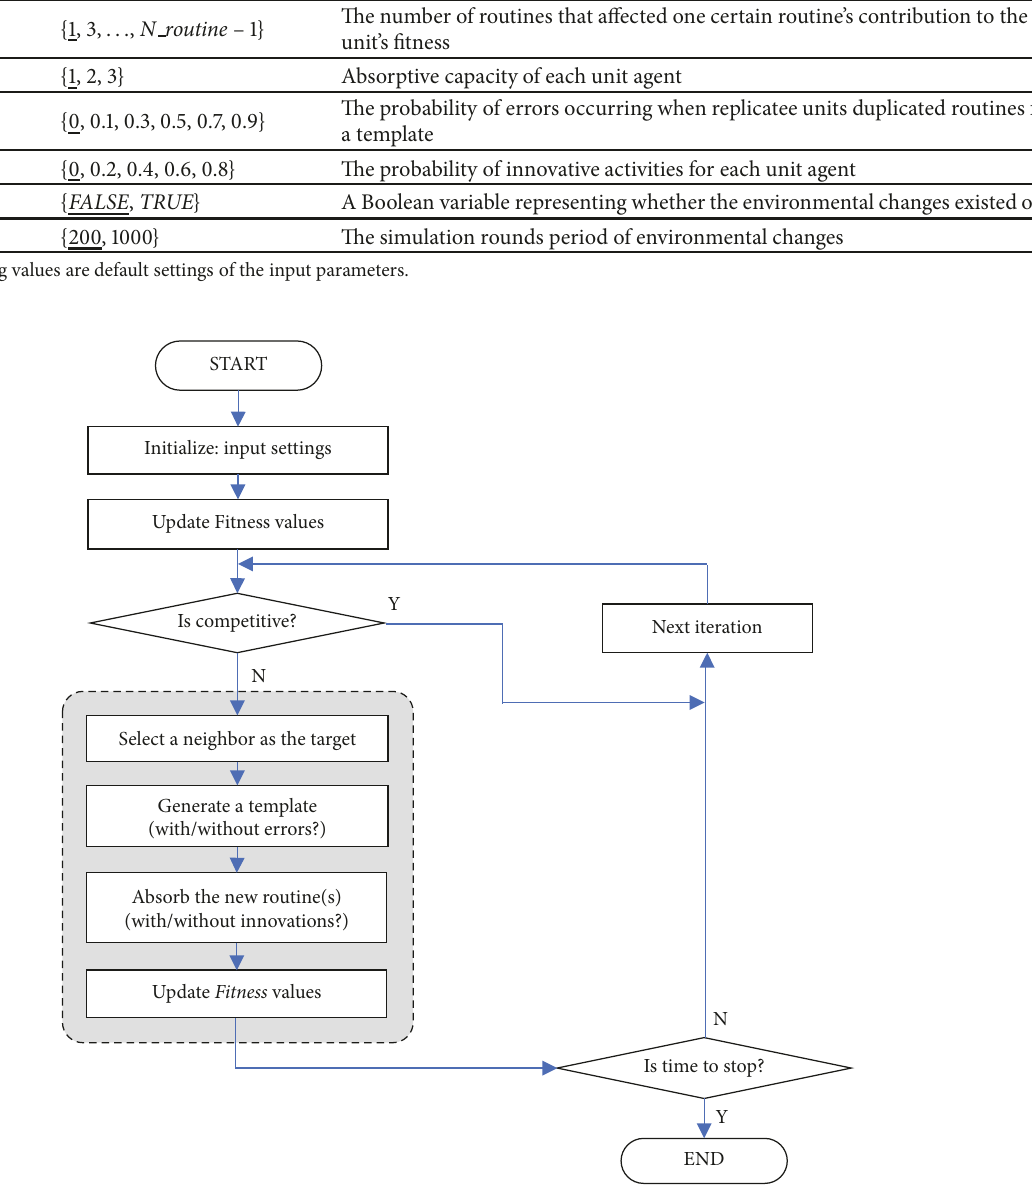
Figure 4: Flow chart of replicating activities between unit